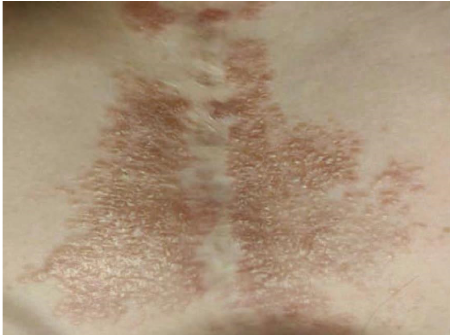
Figure 1: A scaly, erythematous patch on the anterior chest surrounding a previous surgical scar.